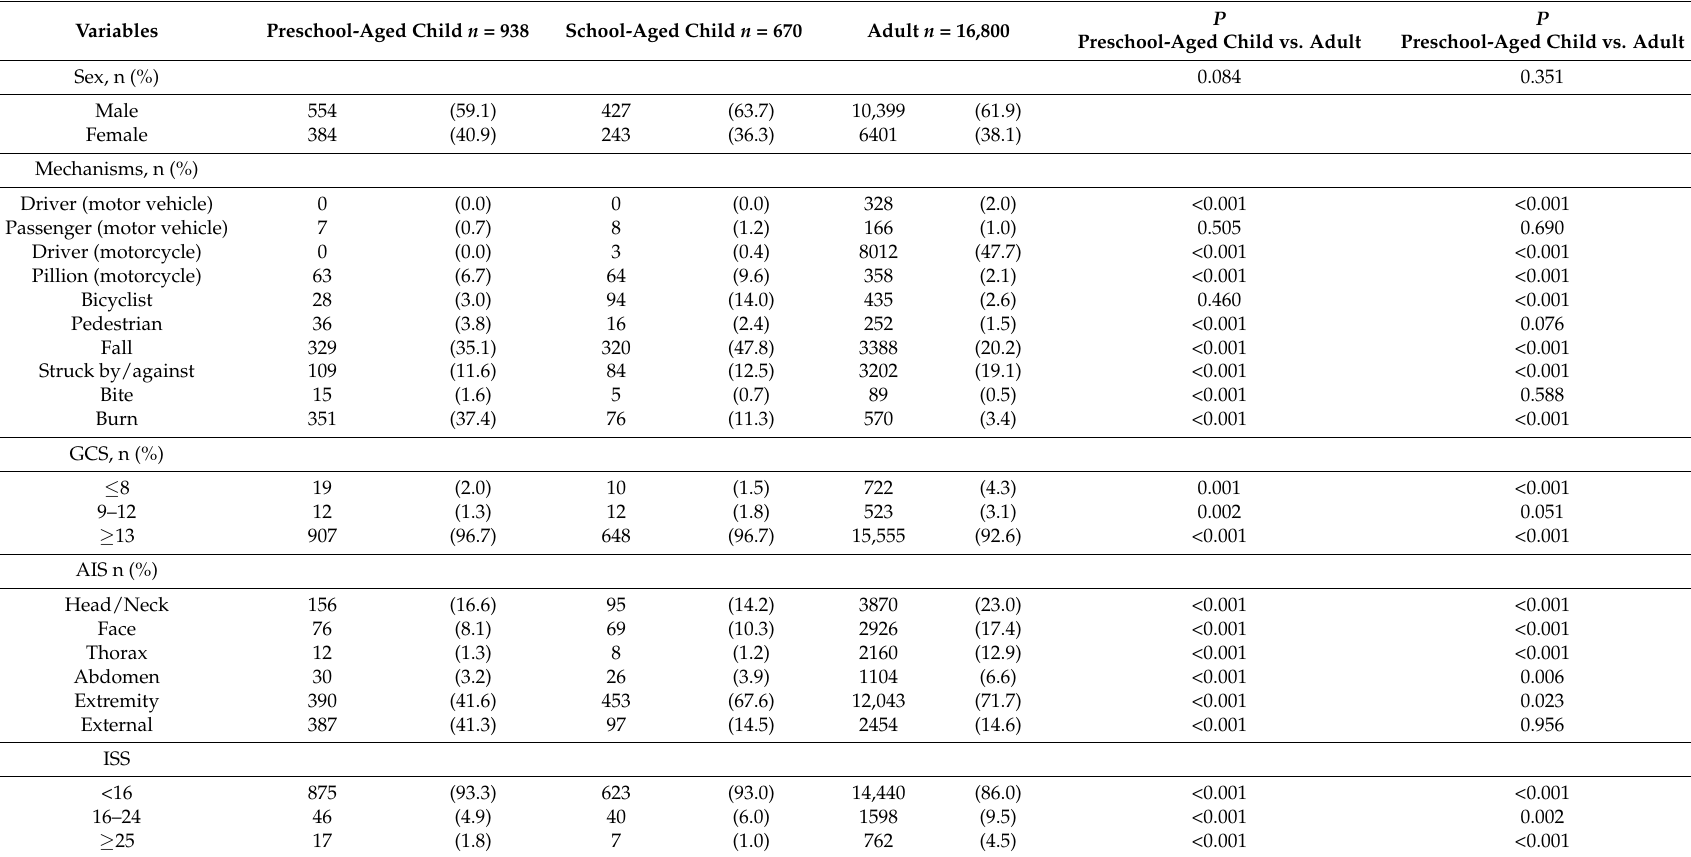
Table 1. Injury characteristics of categorical variables in preschool-aged children, school-aged children, and adults.